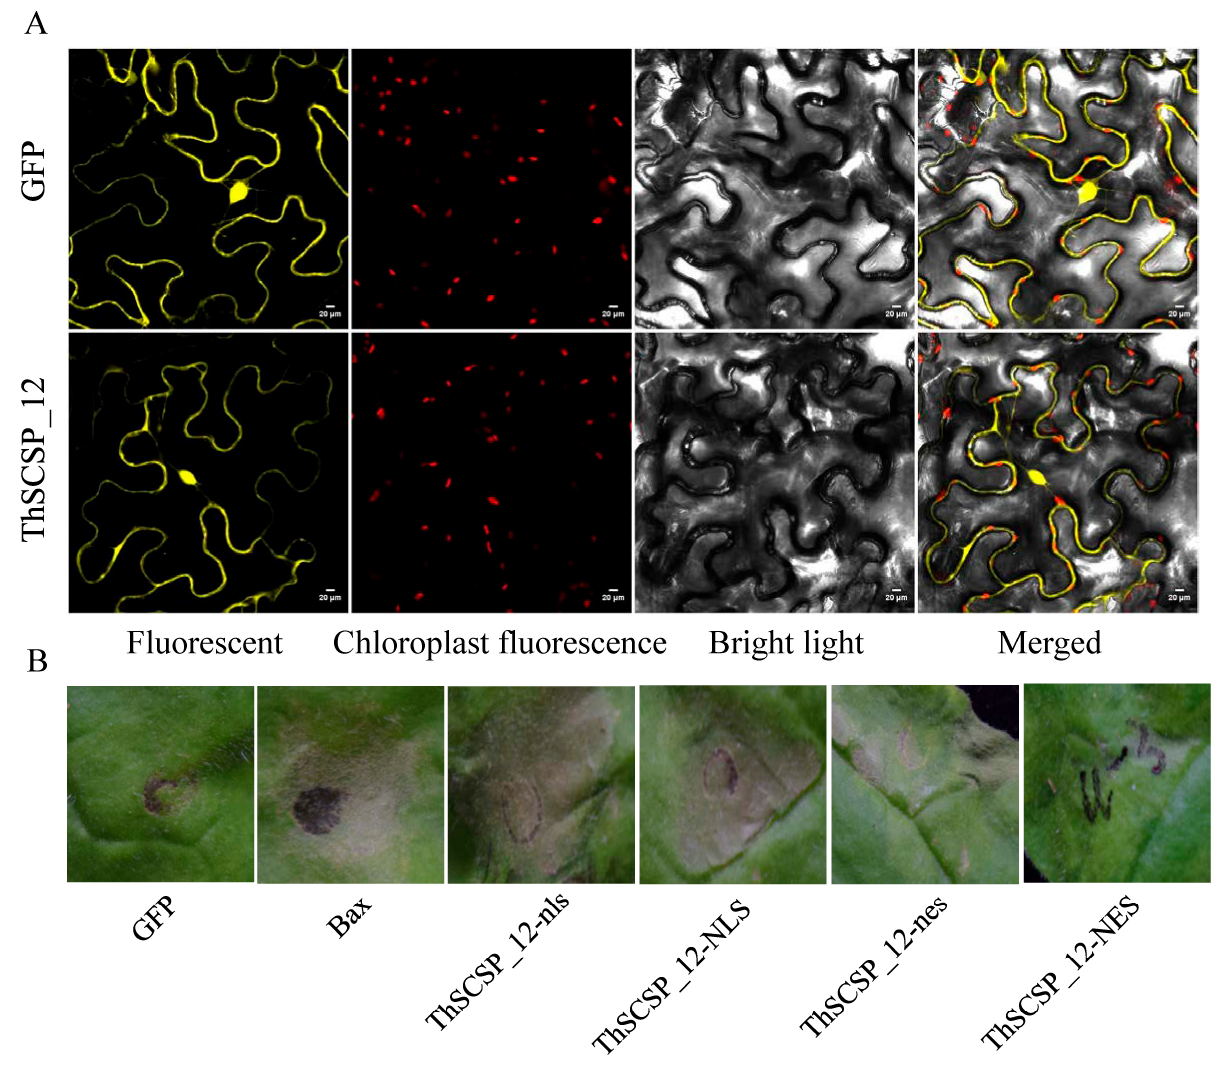
Figure 4. Nuclear localization of ThSCSP_12 is required to induce cell death. ( A ) Subcellular localization of ThSCSP_12-SP transiently expressed in Nicotiana benthamiana leaves. The vector PHB carrying YEP served as a control. Bars = 20 μ m. ( B ) Cell death triggered by nuclear export signal (NES) targeted ThSCSP_12 is both delayed and weak. Photographs were taken at 4 days post-inoculation (dpi). Each treatment was performed using at least three biological replicates.